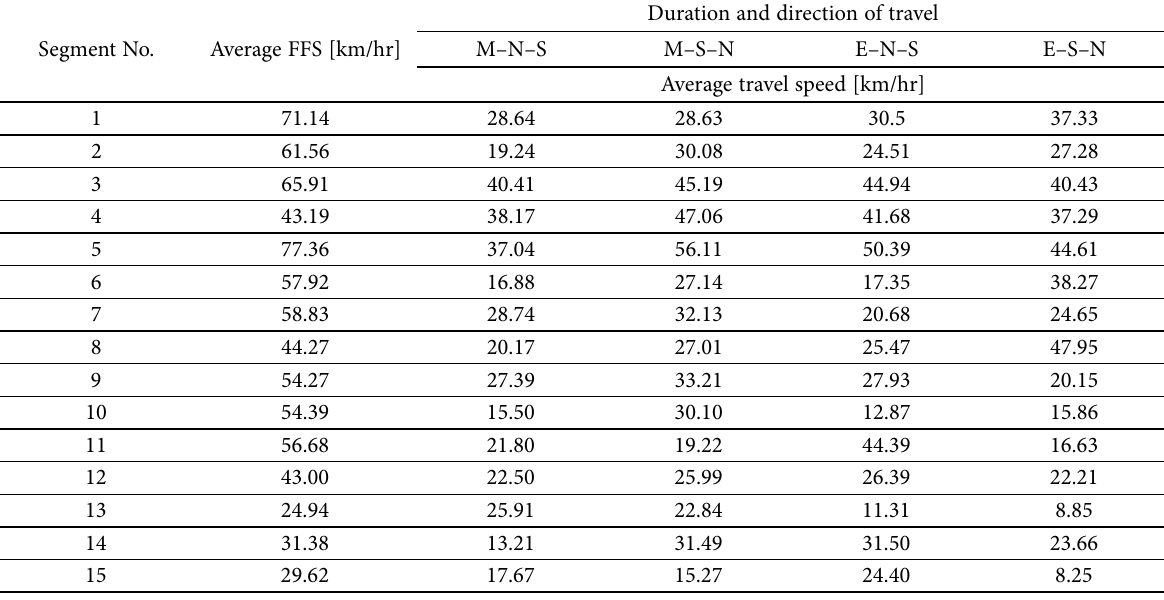
Table 1. FFS and average travel speed during peak and off peak hours of Corridor-3